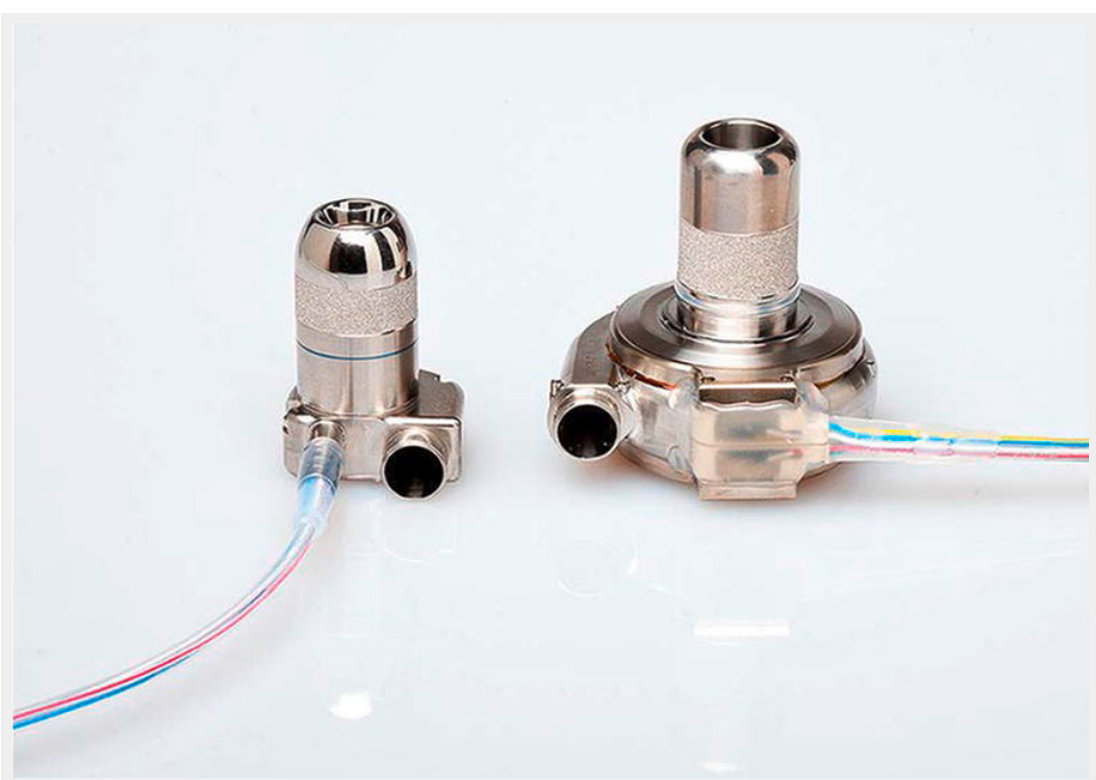
Figure 4 The MVAD (HeartWare Corporation; Framingham, Massachussetts, USA). New generation devices are significantly smaller and lighter than previous generations. They have the possibility to adapt the orientation of the inflow cannula after the insertion to reduce the risk of inflow cannula